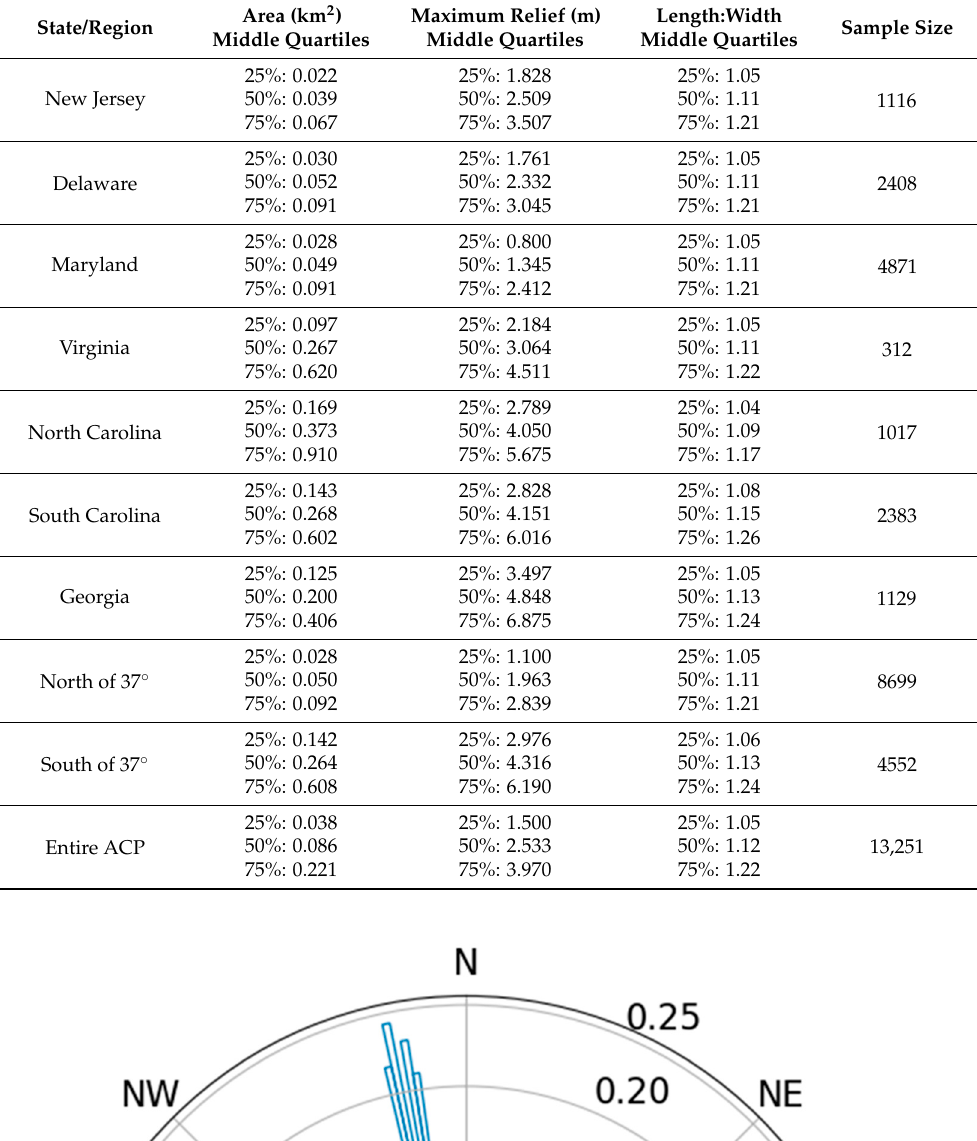
Table 3. Area, max. relief, and length to width ratio middle quartiles for subsets of the Carolina Bay detections.